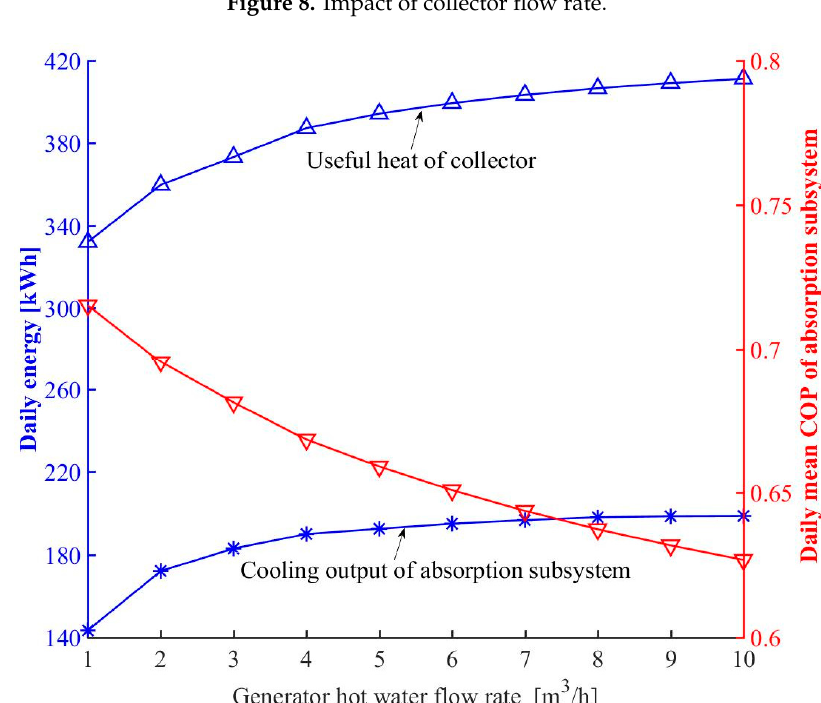
Figure 9. Impact of generator flow rate.